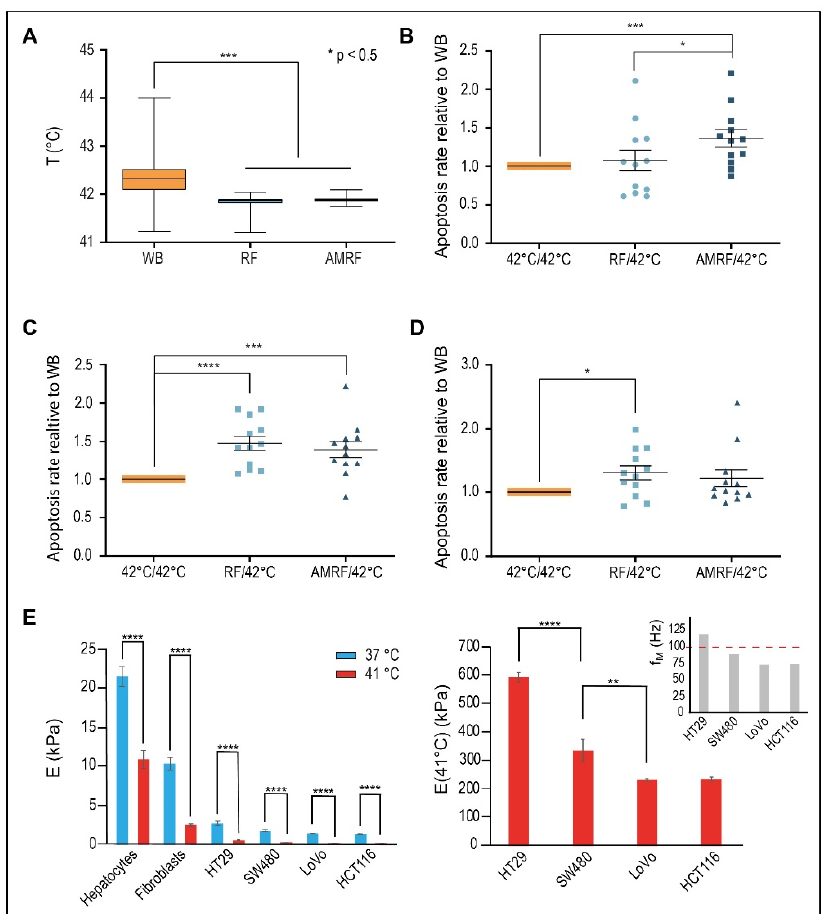
Figure 4. ( A ) Measured temperatures in vitro. Mean temperatures during the 60-min treatment time measured in the cell chamber for RF or AMRF in comparison to the water bath (WB). A sample of 26 biological experiments enclosing all cell lines was evaluated. ( B ) Normalized apoptosis rate in vitro for HT29 cells. Evaluation of apoptosis rates (annexin V+) for HT29 cells in suspension in the in vitro applicator comparing RF and AMRF versus those of cells in a water bath adjusted to 42 ◦ C by normalizing to the mean apoptosis rate of the WB experiments. Significantly higher apoptosis rates are detected in the AMRF arm. Estimated ground natural frequency of the membrane f M is covered by the AM spectrum (see ( E )). ( C ) Normalized apoptosis rate in vitro for SW480 cells. Apoptosis rates are equally enhanced in the RF and AMRF arms. Estimated ground natural frequency of the membrane f M is slightly below the AM spectrum (see ( E )). ( D ) Normalized apoptosis rate in vitro for LoVo cells. Apoptosis rates are equally enhanced in the RF and AMRF arms. Estimated ground natural frequency of the membrane f M is clearly below the AM spectrum (see ( E )). ( E ) Young ´ s moduli E for different cell lines and temperatures, as determined by atomic force microscopy indentation. The overview (left panel) shows that normal issue cells (hepatocytes and fibroblasts) have higher E than cancer cells. A significant drop of E occurs for each cell type as the temperature increases from 37 ◦ C to 41 ◦ C. The more detailed representation (right panel) shows that the moduli at 41 ◦ C significantly differ between cancer cells and lead to different resonance frequencies f M , which are below or above 100 Hz, according to Equation (4) (Section 2 Methods): f M = 120 × E 1/2 × (1/a 2 + 1/b 2 ). Significance was defined as p < 0.05 and marked with * (< 0.005 with **,